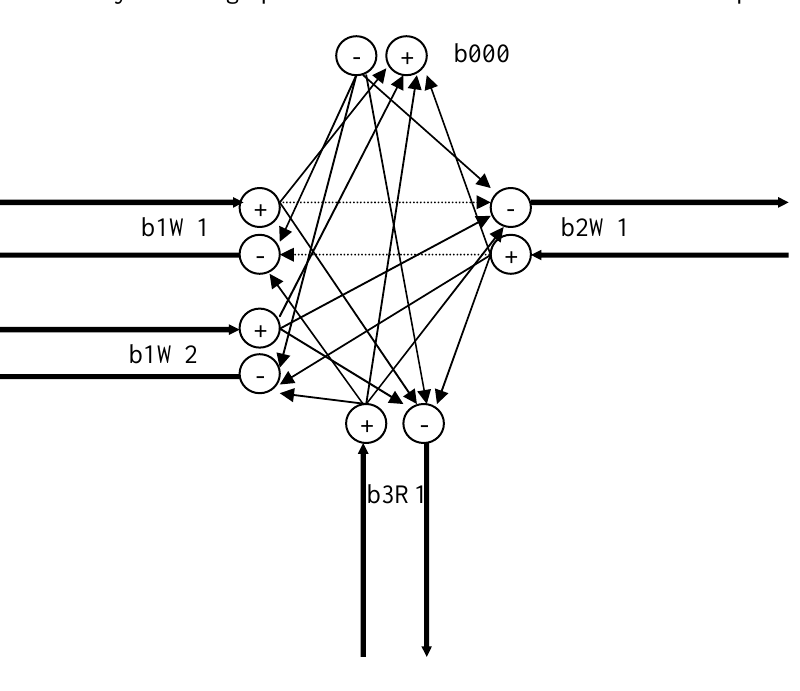
Figure 3. Detailed virtual network at